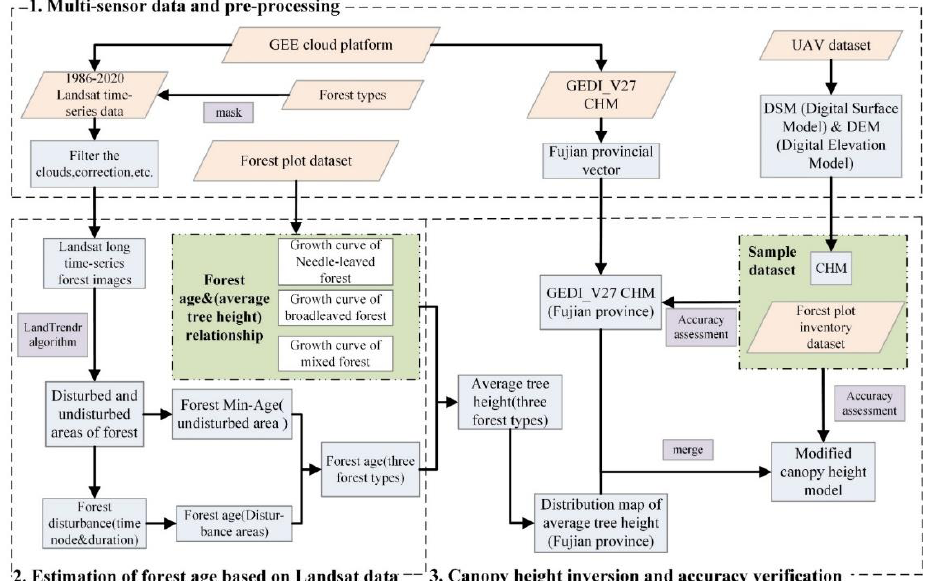
Figure 3. Overall technical flowchart for estimating forest canopy height combining time-series optical remote sensing and GEDI satellite-based LiDAR data.